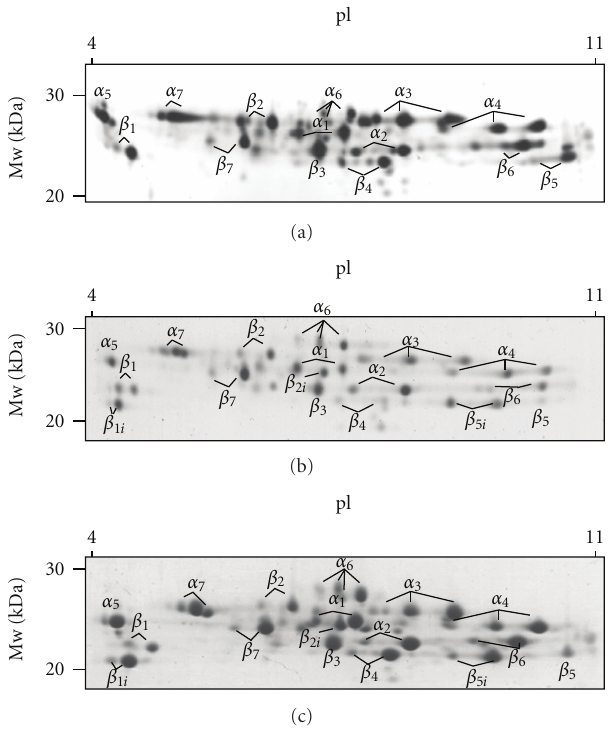
Figure 4: 2D-PAGE of purified 20S proteasomes from (a) red cells (5 μ g), (b) BAL-supernatant (20 μ g) from ARDS patients, and (c) spleen (30 μ g). Detection of protein spots was performed by silver staining and Coomassie BB G250, respectively. Standard 20S pro- teasome was exclusively detected in red cells (a). Samples of human spleen and of the BAL supernatants from ARDS patients showed both standard and immunoproteasome proteins (panels (b) and